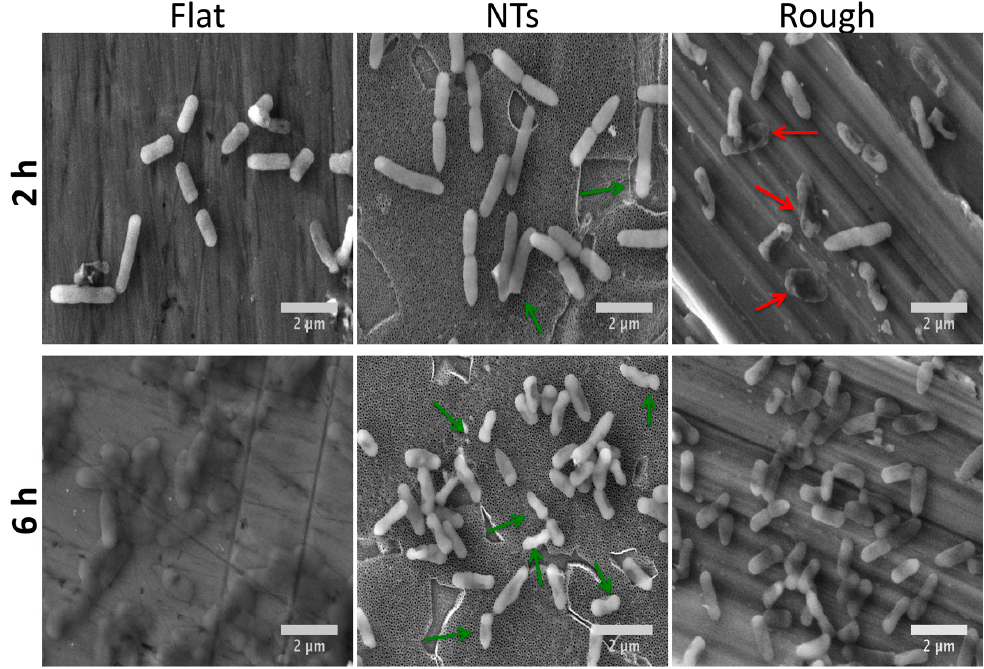
Figure 7. P. aeruginosa aggrupation on the materials at 2 and 6 h of growth. Red arrows symbolize aberrant bacilli morphology on the rough material. Green arrows highlight the deformed bacilli structure of the NTs.